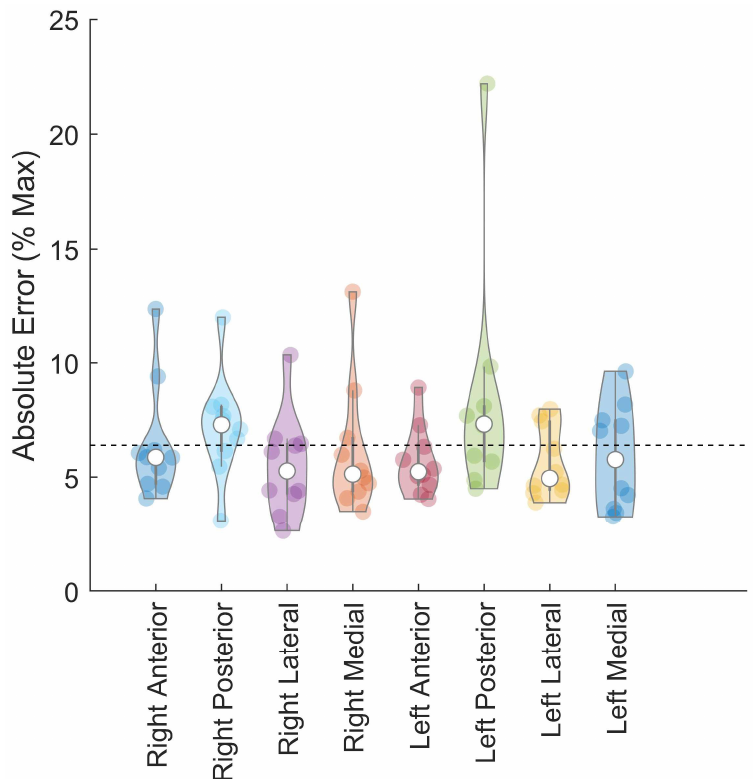
Figure 5. Violin plot of absolute error (% Max) during the force control task for each limb (right, left) and all directions (anterior, posterior, medial, lateral). Median absolute error indicated by open circle, interquartile ranges are represented by thick and thin vertical lines, and overall average is indicated by dashed line. Shaded circles represent individual subject data. * p < 0.05 (one-tailed t -test).